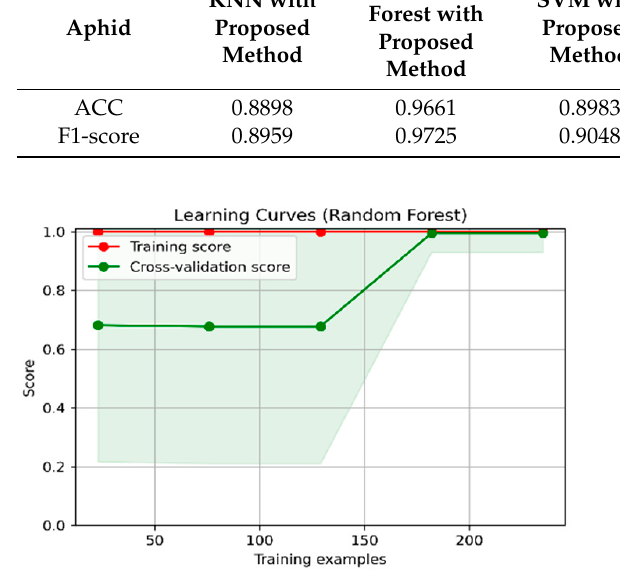
Figure 14. Learning curve for the random forest model of aphid pests.